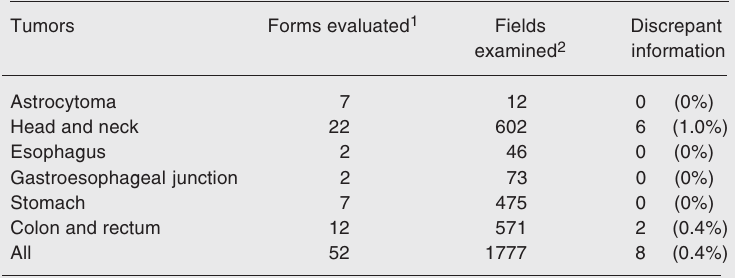
Table 4. Evaluation of data entry consistency in the pathology